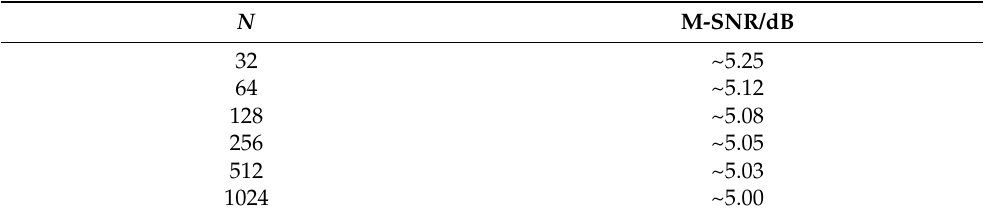
Table 5. M-SNR of the relationship change point in different code